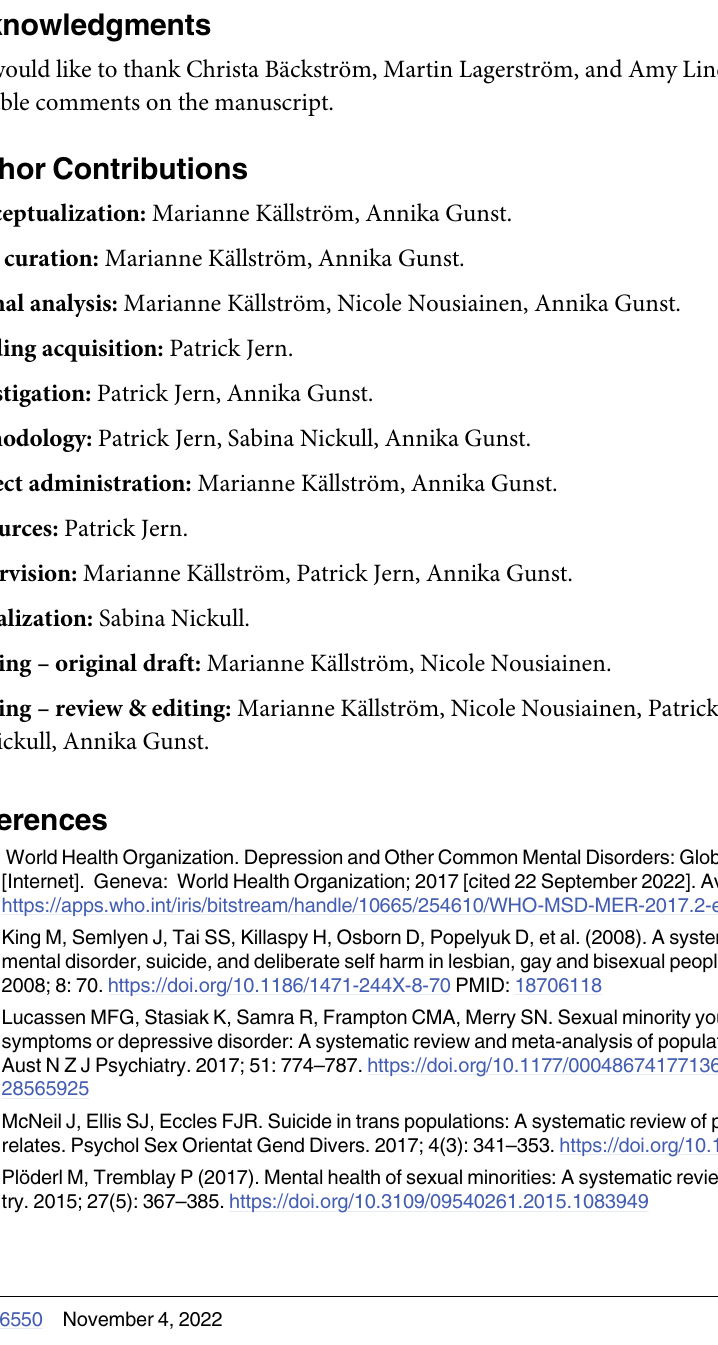
S1 Table. Comparison of anxiety and depression symptom scores by gender